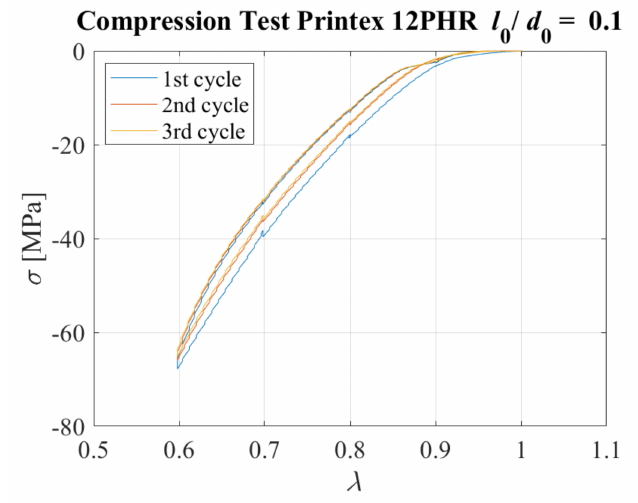
Figure 21. Compressive stress − strain curves for 3 cycles. Specimen with l 0 / d 0 = 0.1.